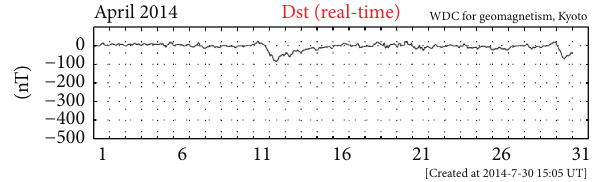
Figure 4: Behavior of Dst-index in April